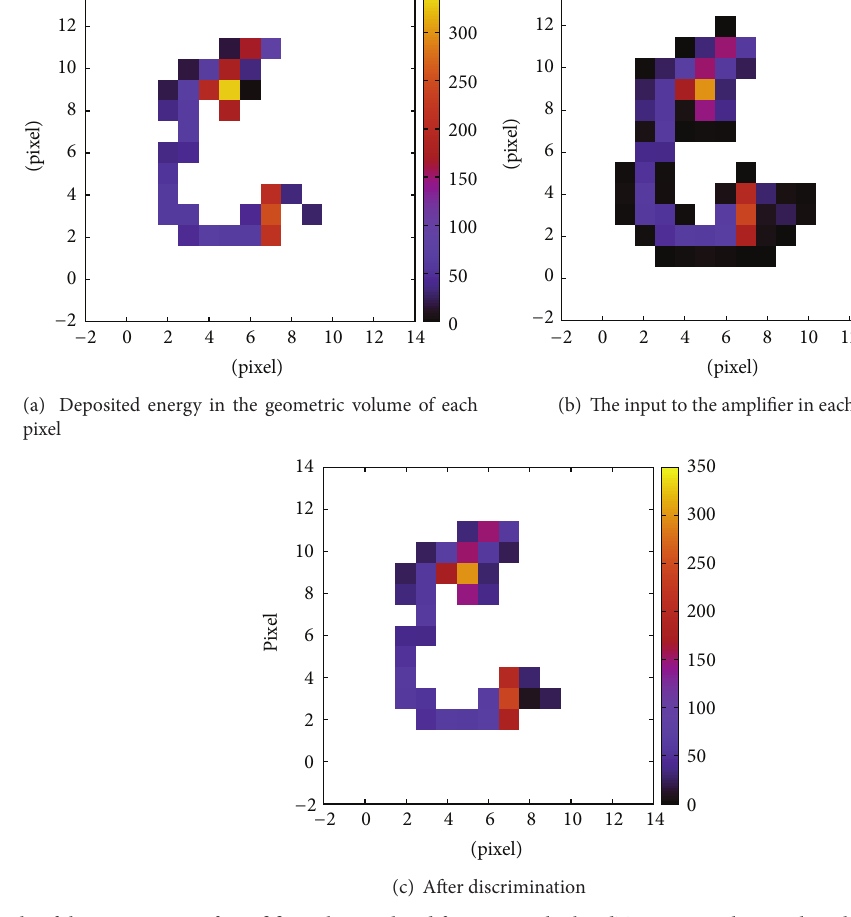
Figure 3: Example of the appearance of a 0 ] 𝛽𝛽 -track, simulated for a 3mm thick CdTe sensor with a pixel pitch of 110 𝜇 m, at different stages of the imaging chain. The x - and y -coordinates give the pixel row and column. The color bar gives the deposited or measured (time-over- threshold) energy in